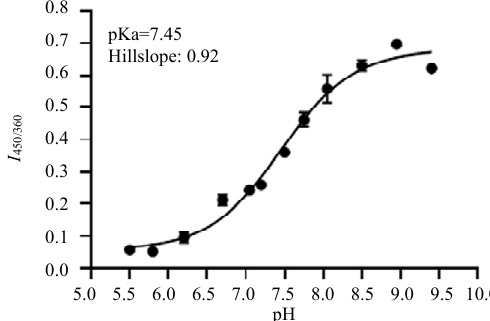
Fig. 5 Plot of pH versus I 450/360 (emission 520 nm). Data mean ±SEM experiment performed duplicate.